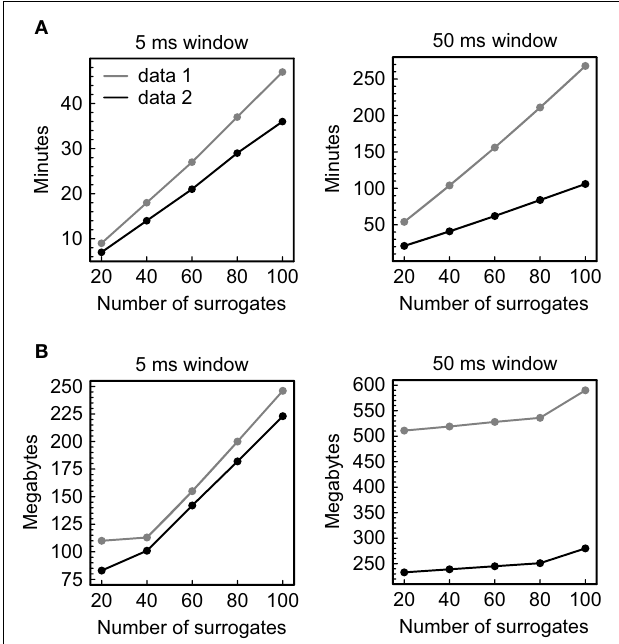
FIGURE 8 | Computational demands of the analysis. Parallel recordings of multineuronal spiking activity were scanned for significant spatiotemporal firing patterns and pattern sequences using the temporal order of spikes to define patterns. Data 1 comprises ∼ 194000 spikes recorded simultaneously from 66 units in 96min, data 2 comprises ∼ 93000 spikes recorded simultaneously from 73 units in 96min. (A) Dependence of the processing time on the number of surrogates and the window size used for pattern detection. (B) Dependence of the memory consumption on the number of surrogates and the window size used for pattern